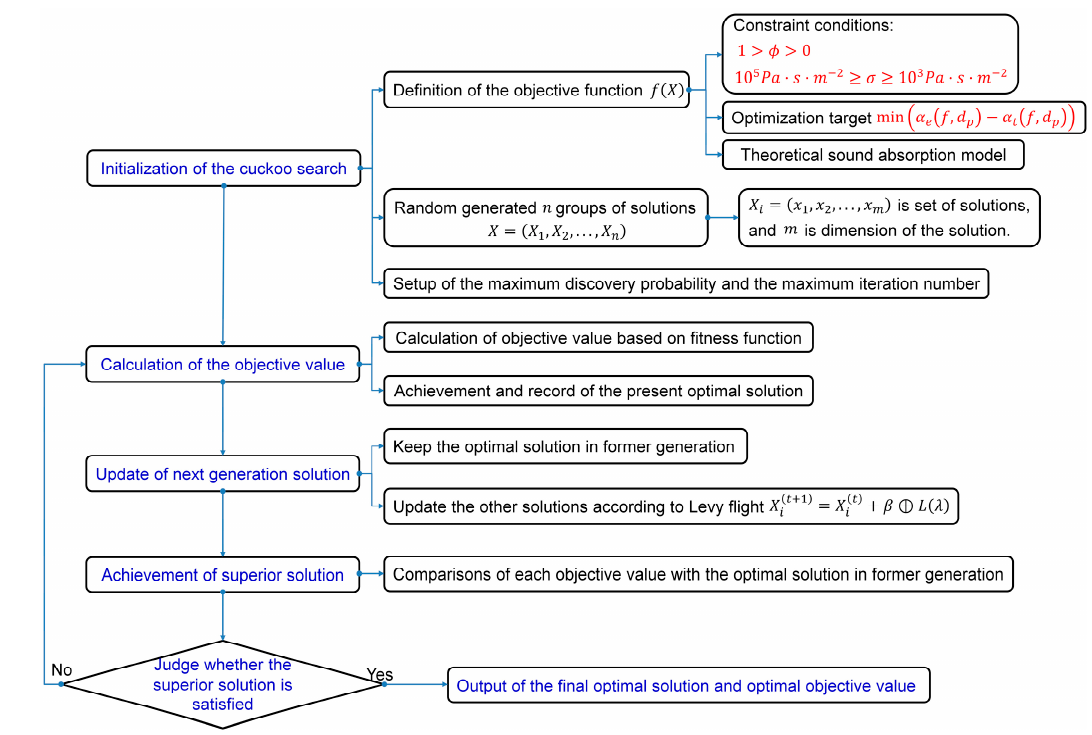
Figure 3. Flow chart of identification of the acoustic characteristic parameters through the cuckoo search algorithm.